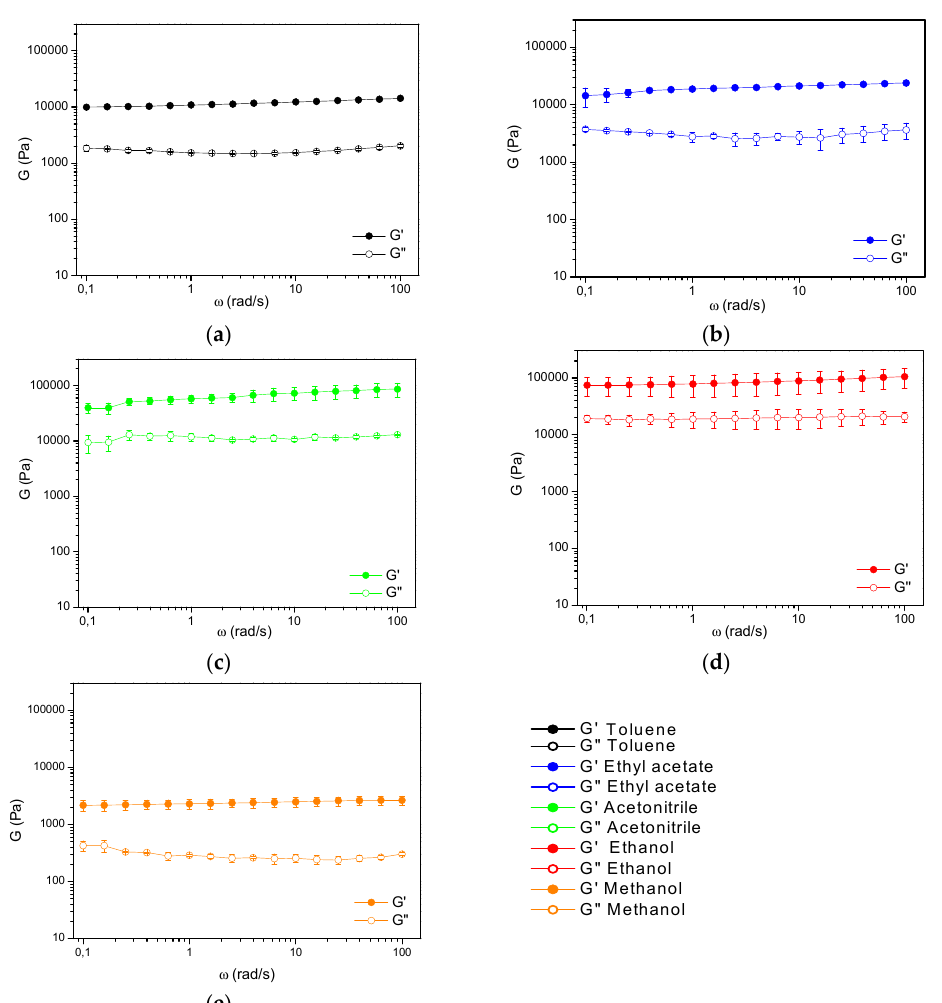
Figure 2. Frequency sweep experiments performed on the 2% w / w gels in the solvents listed by increasing polarity: ( a ) toluene (black); ( b ) ethyl acetate (blue); ( c ) acetonitrile (green); ( d ) ethanol (red); ( e ) methanol (orange). The analyses were performed on the gels about 20 hours after the gelation begun. For more details see the Materials and Methods section.